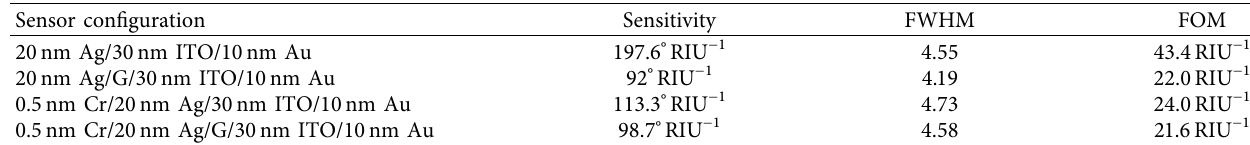
Figure 7. The sensitivities of 20 nm Ag/30 nm ITO/10 nm Au and 20 nm Ag/G/30 nm ITO/10 nm Au without the Cr layer were 197.6 ° RIU − 1 (FWHM � 4.55, FOM � 43.4 RIU − 1 ) and 92 ° RIU − 1 (FWHM � 4.19, FOM � 22.0 RIU − 1 ), respectively.